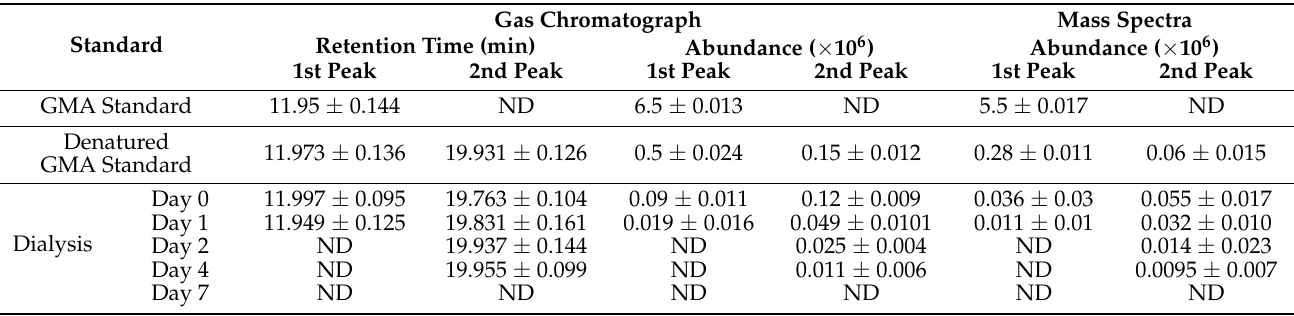
Table 2. The GC-MS analysis of retention time and abundance value for dialysis days 0, 1, 2, 4, and 7. Analyses were compared with GMA and denatured GMA standard at 60 ◦ C for 6 h, and each dialyzed sample of Silk-GMA. GMA, glycidyl methacrylate; ND, not